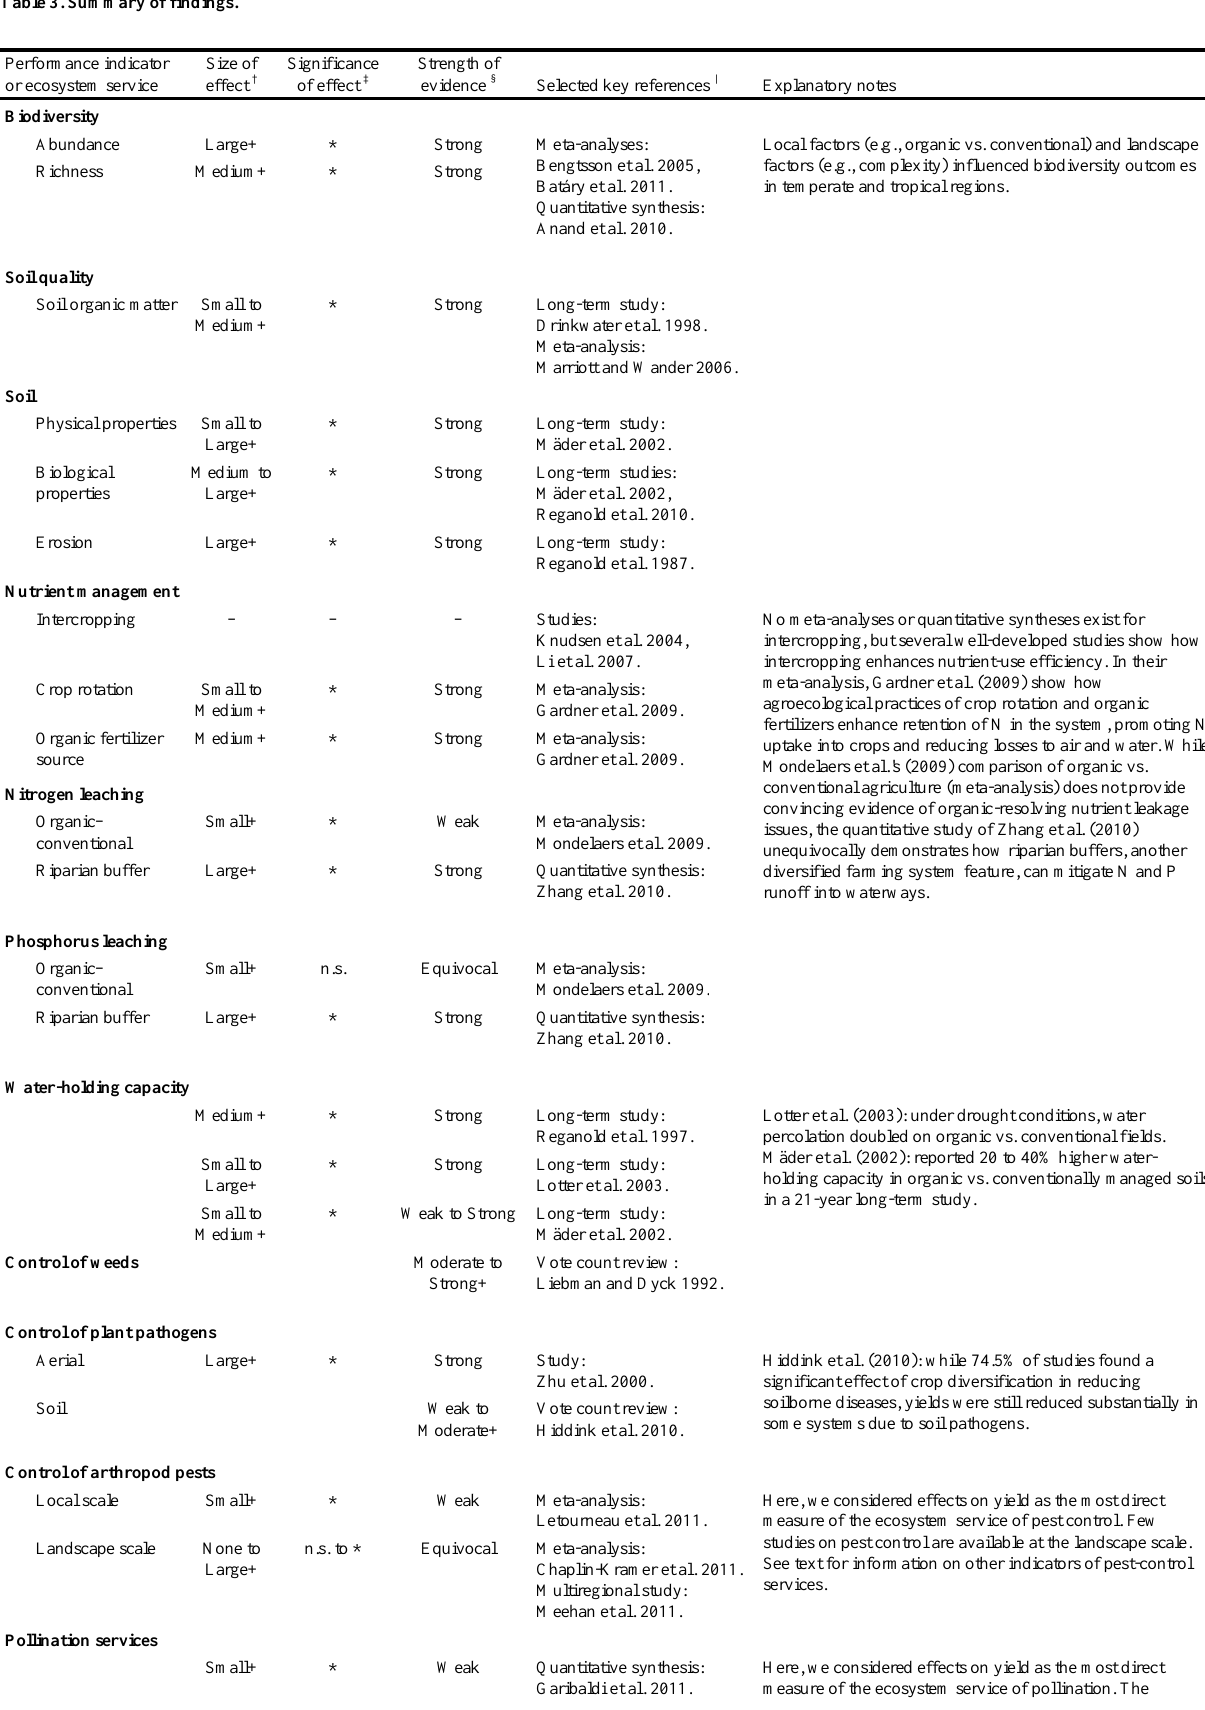
Table 3. Summary of